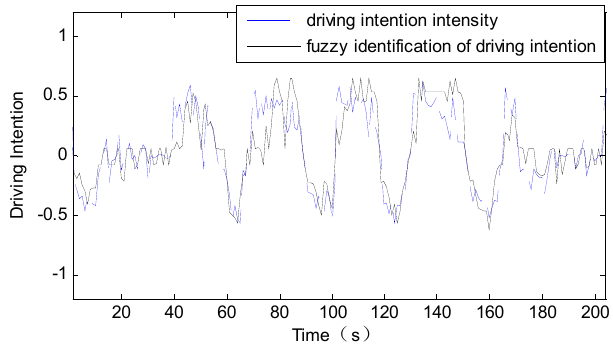
Figure 7. The driving intention identification result comparison.